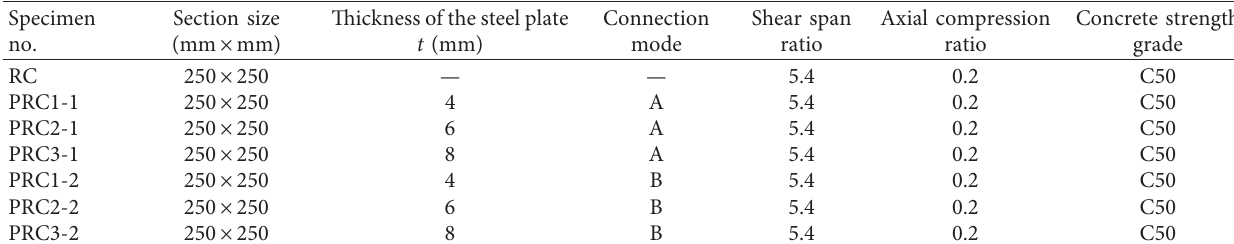
Table 1: Design parameters of